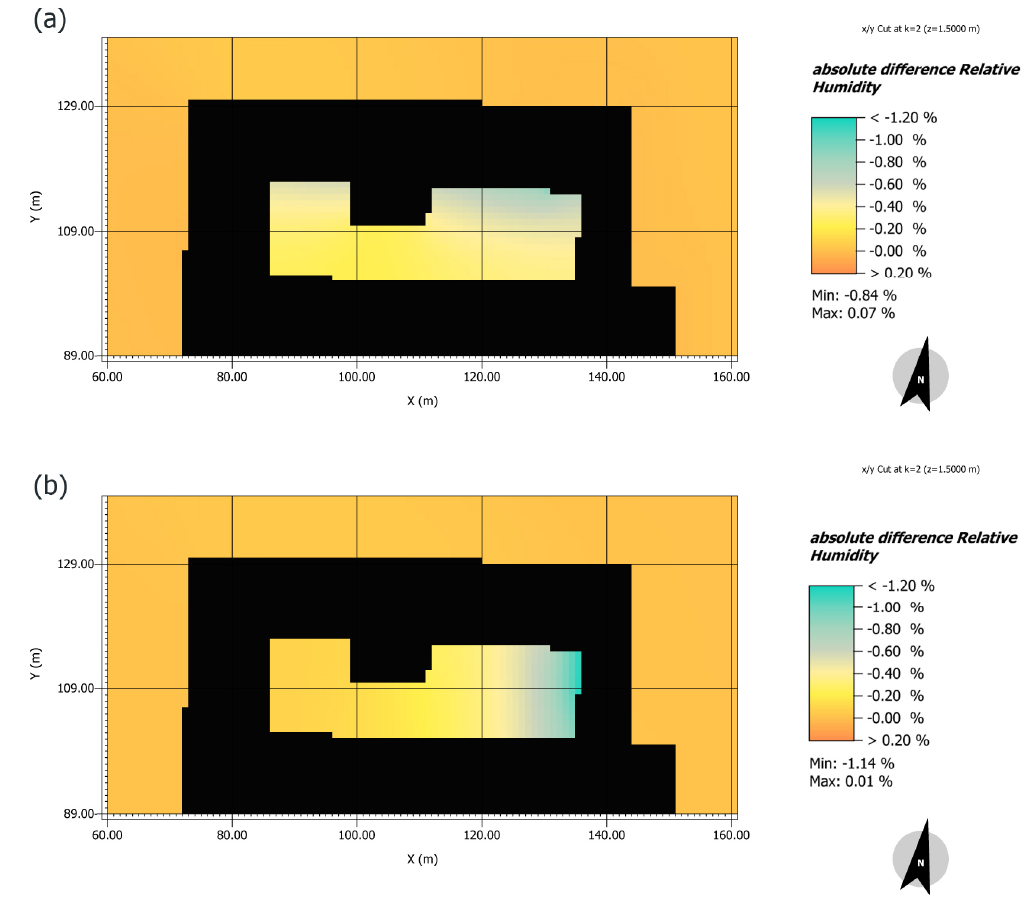
Figure 12. The comparison of initial state with reference green wall relative humidity at the height of 1.5 m in the scenario with greenery placed on the northern ( a ) and eastern ( b ) wall. Figure by authors.